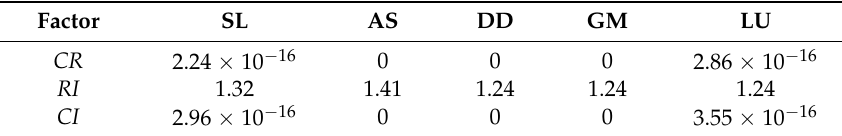
Table 5. The CR , RI , and CI of calculating factors’ weights by the AHP.